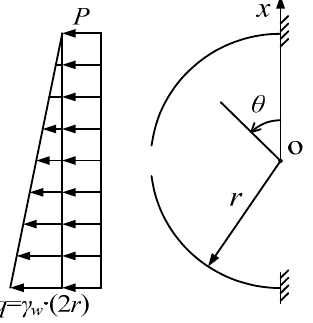
Figure 4. Load diagram of pressurized water conveyance.